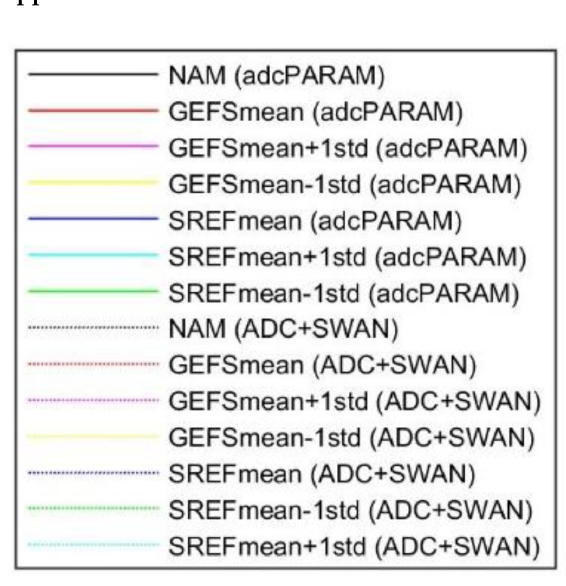
Figure A1. Legend for Figures